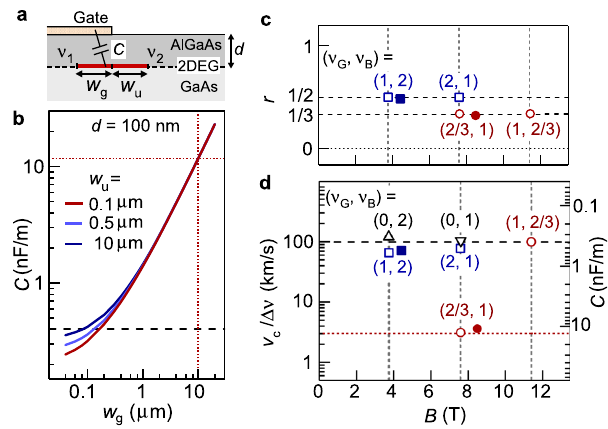
Fig. 4 Velocity of the interface mode. a Schematic cross-section around the interface channel Δ ν = | ν 1 − ν 2 | of width w g + w u ( w g in the gated region and w u in the ungated region) between two QH states at ν 1 and ν 2 . The interaction inside the channel can be described with geometric capacitance C to the gate. b Calculated capacitance C as a function of w g for several w u values. c Fractionalization factor r for junction Y C obtained at ( ν G , ν B ) = (2/3, 1) and (1, 2/3) showing r ~ 1/3 (circles), and junction Y D at (1, 2) and (2, 1) showing r ~ 1/2. d Normalized charge velocities v c / Δν for fractional Δ ν = 1/3 interface channels at (2/3, 1) and (1, 2/3) marked with circles, integer Δ ν = 1 interface channels at (1, 2) and (2, 1) marked with squares, and conventional edge channels at (0, 2) and (0, 1) marked with triangles. Data obtained after light irradiation are marked with solid symbols. Channel capacitance C is shown on the right scale. Fig. 4a, this C is expected to depend on the width, w = w g + w u , of the channel (compressible region), where w g ( w u ) is the spread under the gate (in the ungated region). Our numerical simulation than w u (Fig. 4b). The normalized velocities, v c / Δν , obtained for